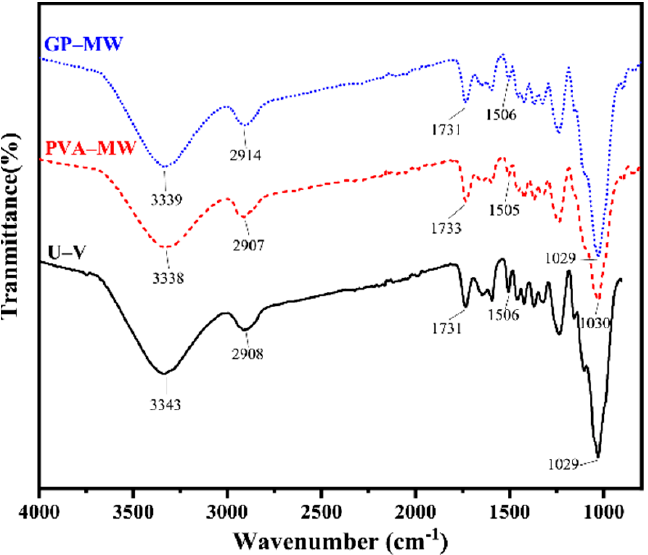
Figure 8. FT-IR spectra of untreated veneer, PVA, and Gr/PVA impregnated modified veneers. It also can be seen that the three test samples all have an absorption peak near 3340 cm − 1 . By comparison with U–V, there is a decrease in the peak transmittance of